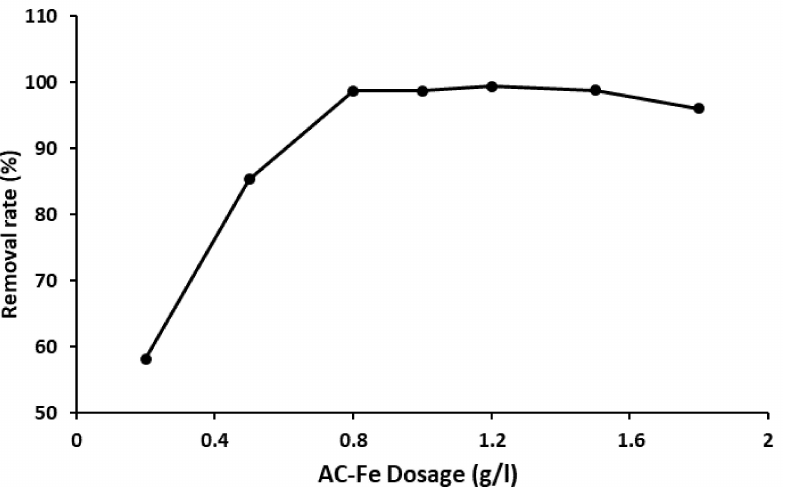
Figure 7. Effect of AC-Fe concentrations on TBO degradation. (pH = 3.5, [TBO] 0 = 50 mg/L, [H 2 O 2 ] = 4 mmol/L, reaction temperature = 20 ◦